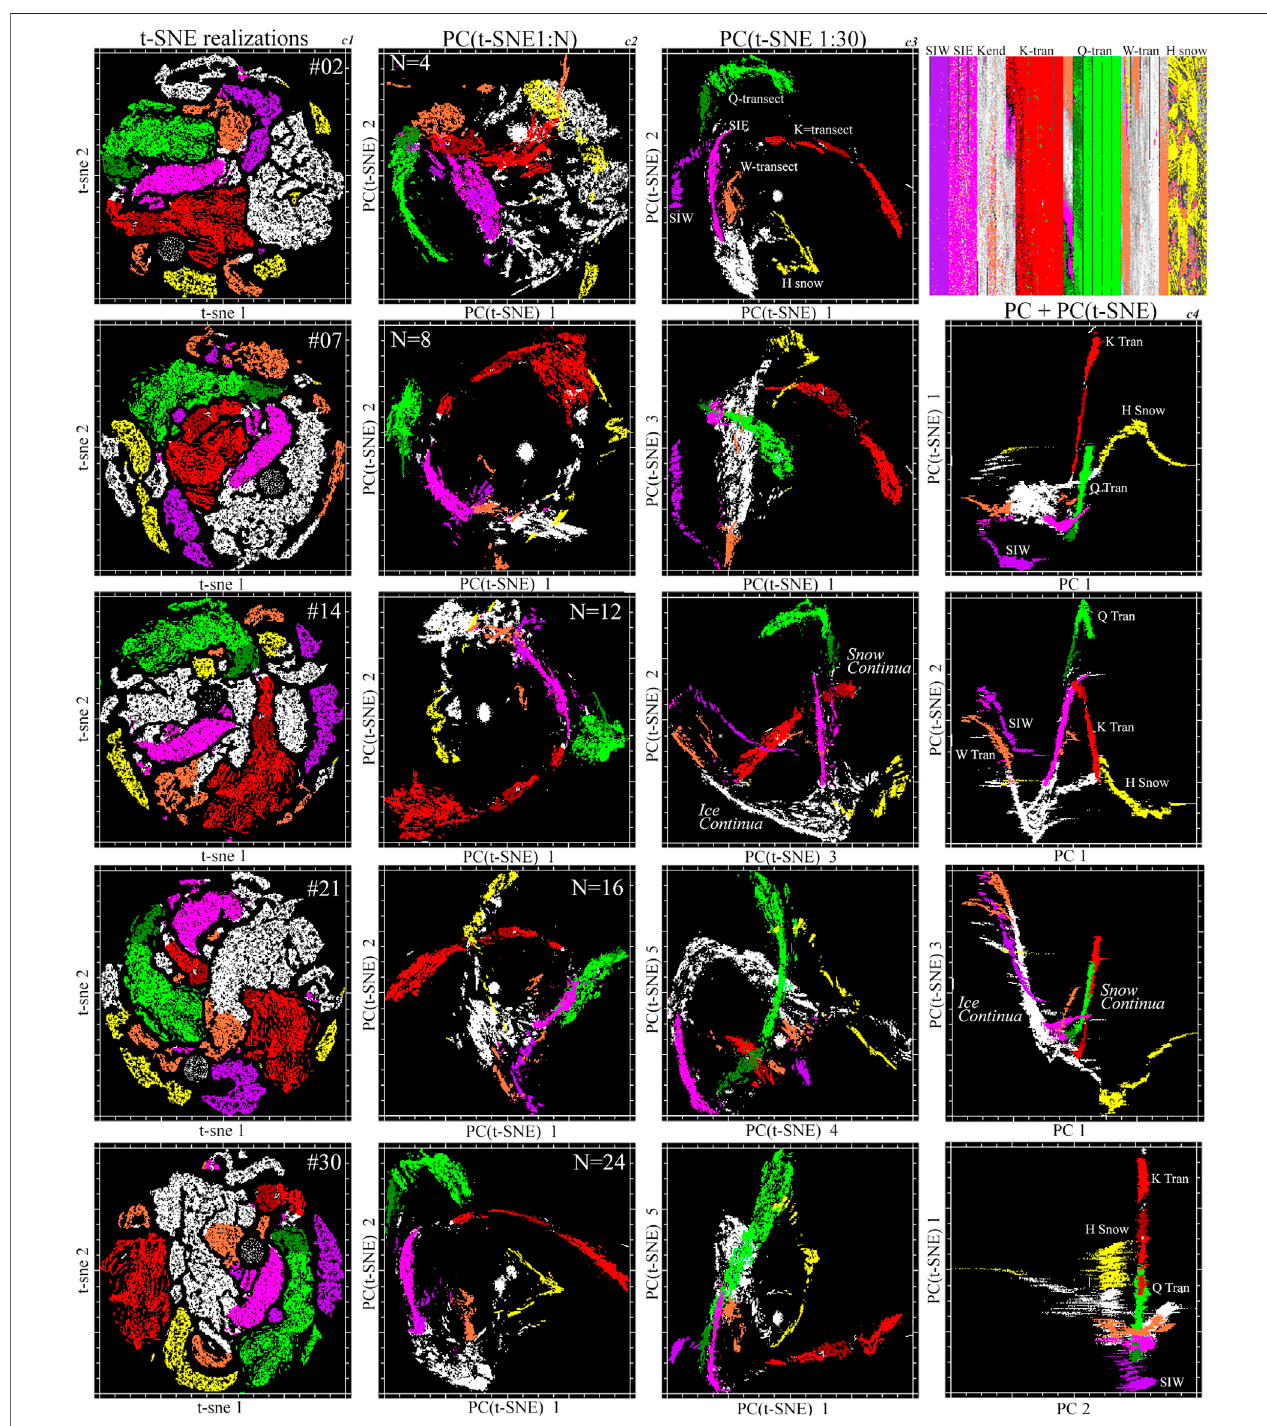
FIGURE 4 | Spectral feature space dis-continua correspond to geographically explicit compositional characteristics. Adjacency of distinct clusters forming elongatelimbsinPC(t-SNE)space(c2andc3)correspondtodistinctclustersineachrealizationoft-SNEspace(c1)andcontinuaofsnowandicere fl ectanceonspeci fi c AVIRIS-NG linesInthePC+PC(t-SNE) space(c4) thePCdimension(x)preservescontinuousvariationsinglobalstructurerelated tospectralshapeandamplitudewhile dis-continuity of distinct labeled clusters (solid colors) in the PC(t-SNE) dimension (y) preserves fi ne scale local features associated with distinct manifolds in the higher dimensional spectral feature space. Note that the geographic speci fi city of some AVIRIS NG lines is preserved in the t-SNE spaces but not in the low order PC space continuum of Figure 2 . The local spectral similarities that yield clusters in t-SNE space do not contribute enough variance to be discernable in the continuous PC space. In contrast, individual ice clusters span multiple AVIRIS NG lines.